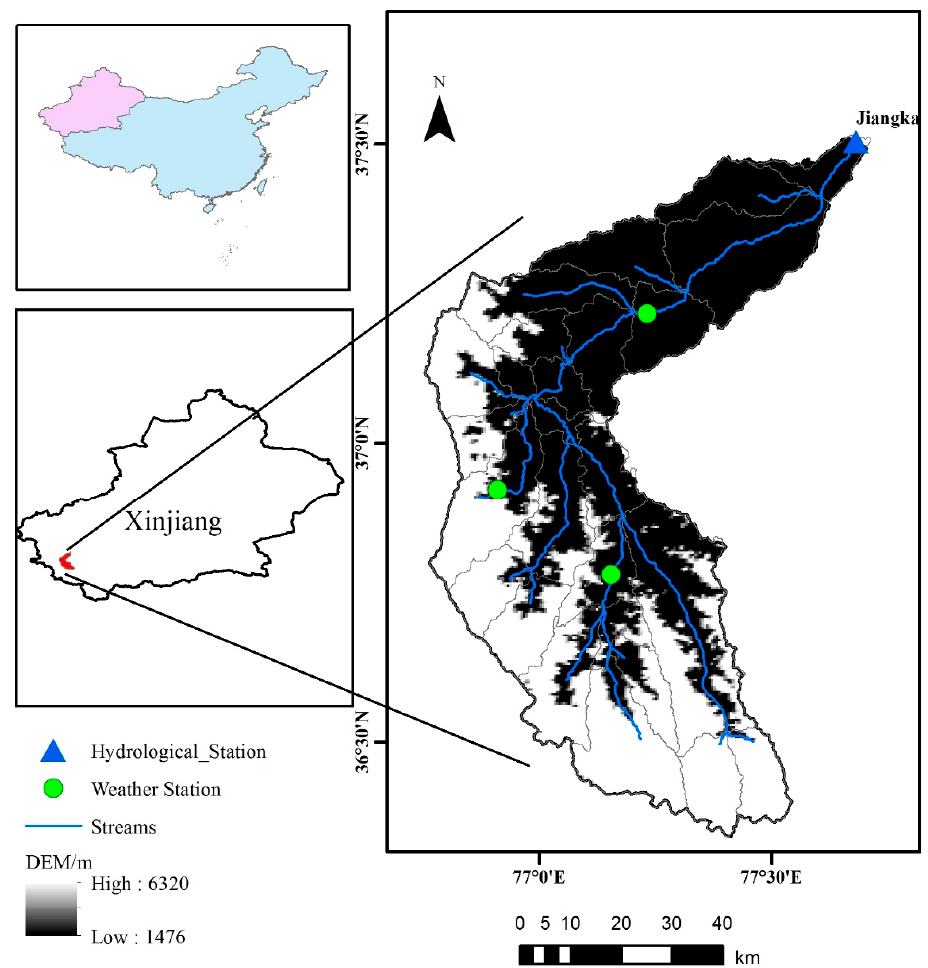
Figure 1. Digital elevation of the Tizinafu River Basin, Kunlun Mountains, Western China.